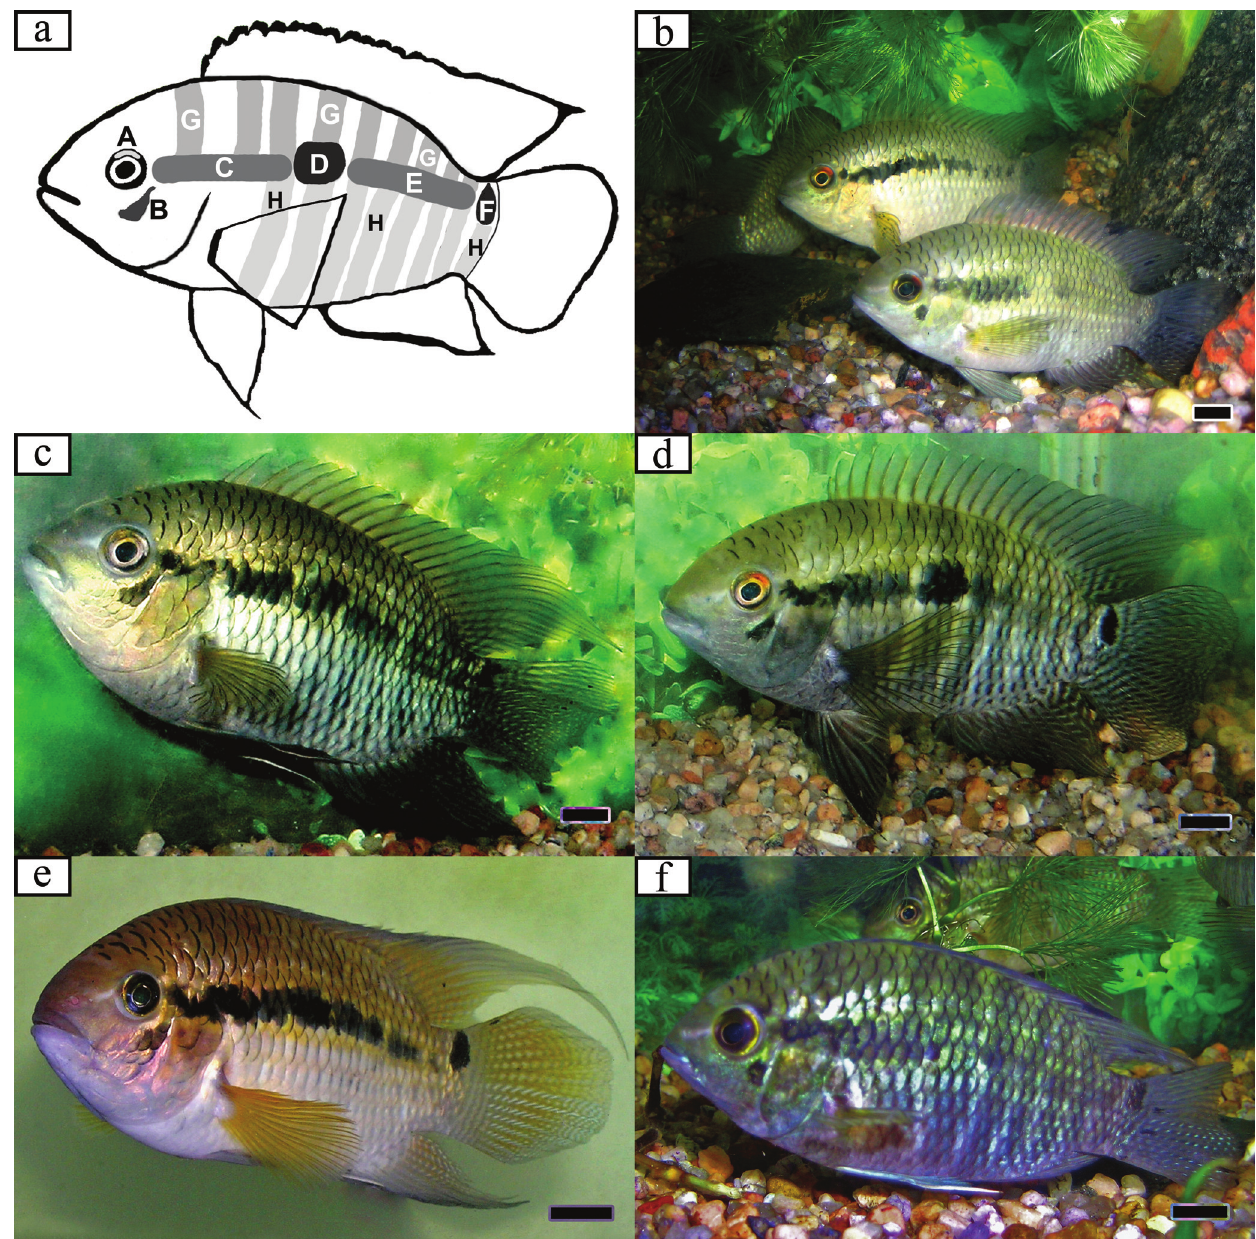
Fig. 2. Body color patterns associated with different social status; a ) Schematic representation of the main features of Cichlasoma dimerus color pattern. A: red eye blotch; B: preopercular blotch, C: anterior longitudinal line; D: mid trunk blotch; E: posterior longitudinal line; F: peduncular blotch; G: dorsal transversal bars; H: ventral transversal bars. These features may “turn on” or “off” in different conditions; b ) Gregarious individuals; c ) Reproductive Territorial male (RT); d ) Reproductive Territorial female. e ) Non Reproductive Territorial male (nRnT); f ) Non Reproductive non Territorial (nRnT) individual. Scale bar = 1